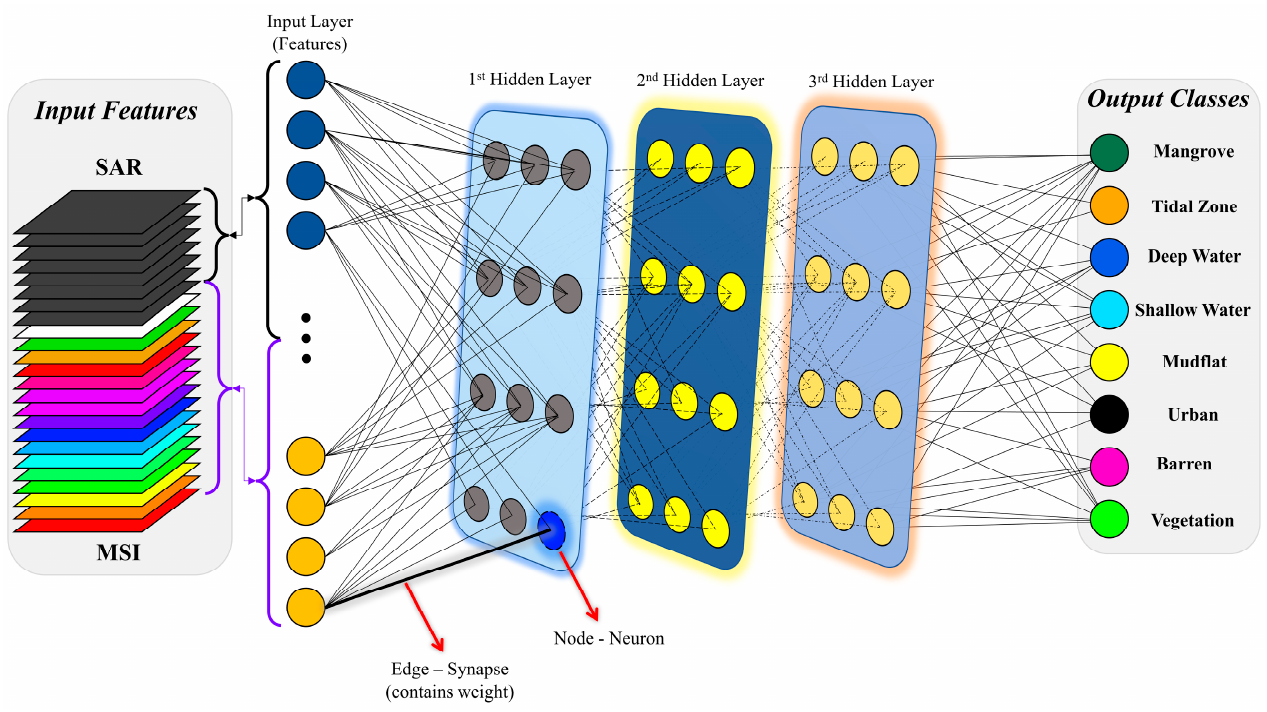
Figure 3. A schematic presentation of an artificial neural network (ANN) for mangrove ecosystem classification.